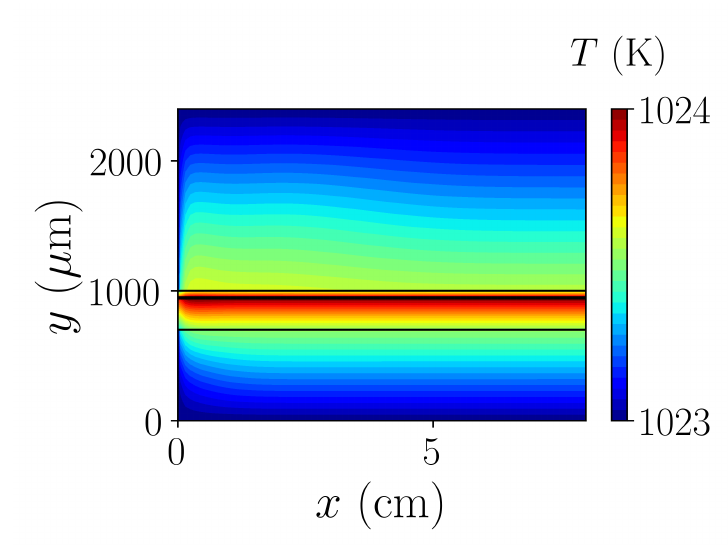
Figure 14. Temperature distribution inside the cell (not in the scale); the cathode channel is on the top.